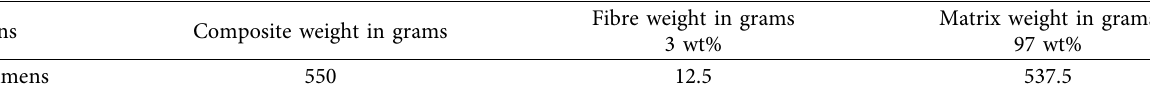
Table 3: Orientation of